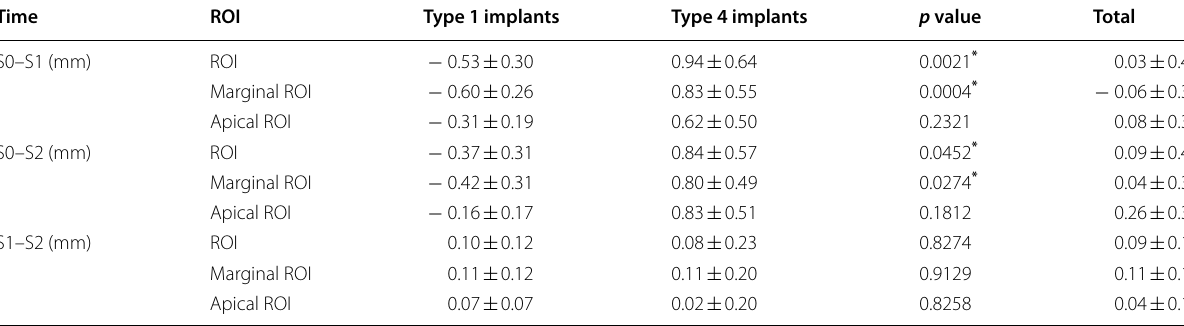
SD) at the 6- and 12-month follow-up ±